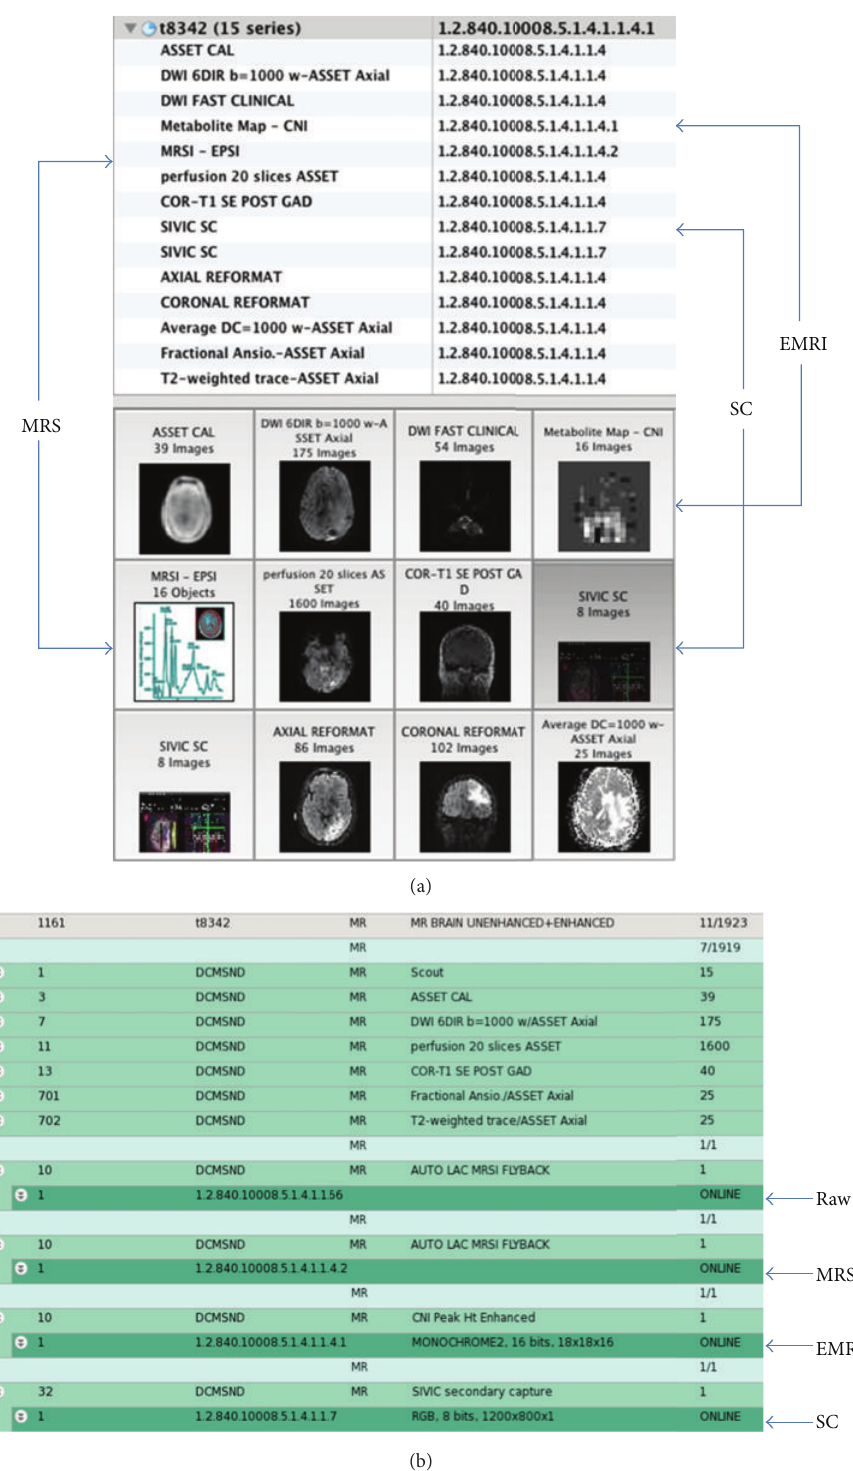
Figure 8: DICOM MRSI exam in OsiriX PACS (a) and DCM4CHEE PACS (b): Raw Data Storage SOP class (1.2.840.10008.5.1.4.1.1.66, RAW), reconstructed MRSI, MR Spectroscopy SOP class (1.2.840.10008.5.1.4.1.1.4.2, MRS), Secondary Capture SOP class (1.2.840.10008.5.1.4.1.1.7, SC), metabolite maps (Enhanced MR Image Storage SOP class (1.2.840.10008.5.1.4.1.1.4.1,